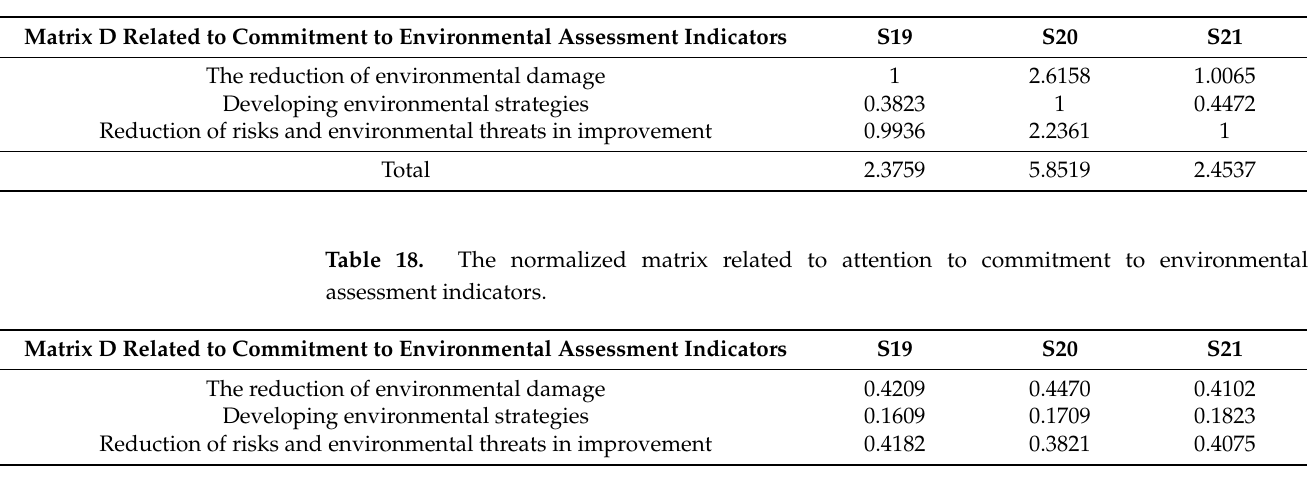
Table 17. Pairwise comparison matrix related to commitment to environmental assessment indicators.